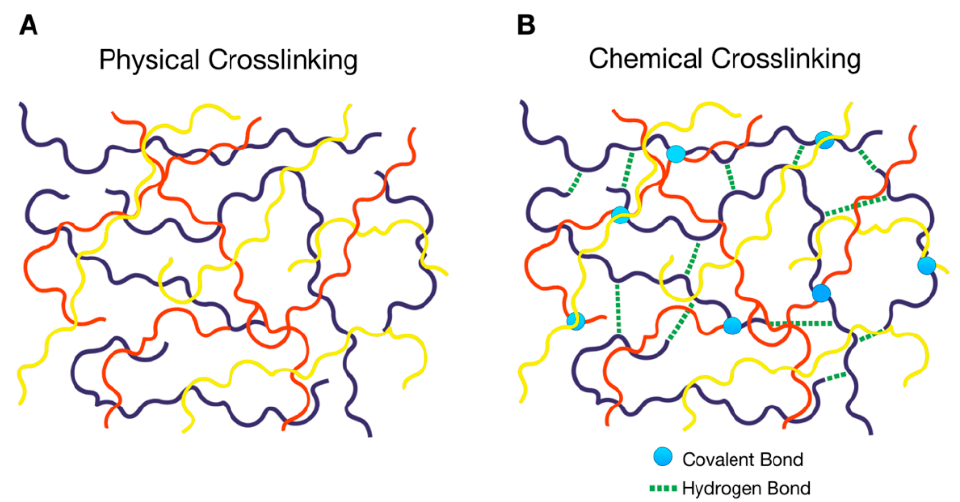
Figure 1. Schematic representation of the types of cross-linking in a polymer hydrogel (PolyHy); ( A ) physical cross-linking of different types of polymeric chains denoted by different colors, ( B ) chemical cross-linking consisting of covalent bonds between the polymeric chains denoted by circles and non-binding interactions such as hydrogen bonds represented by dashed lines.